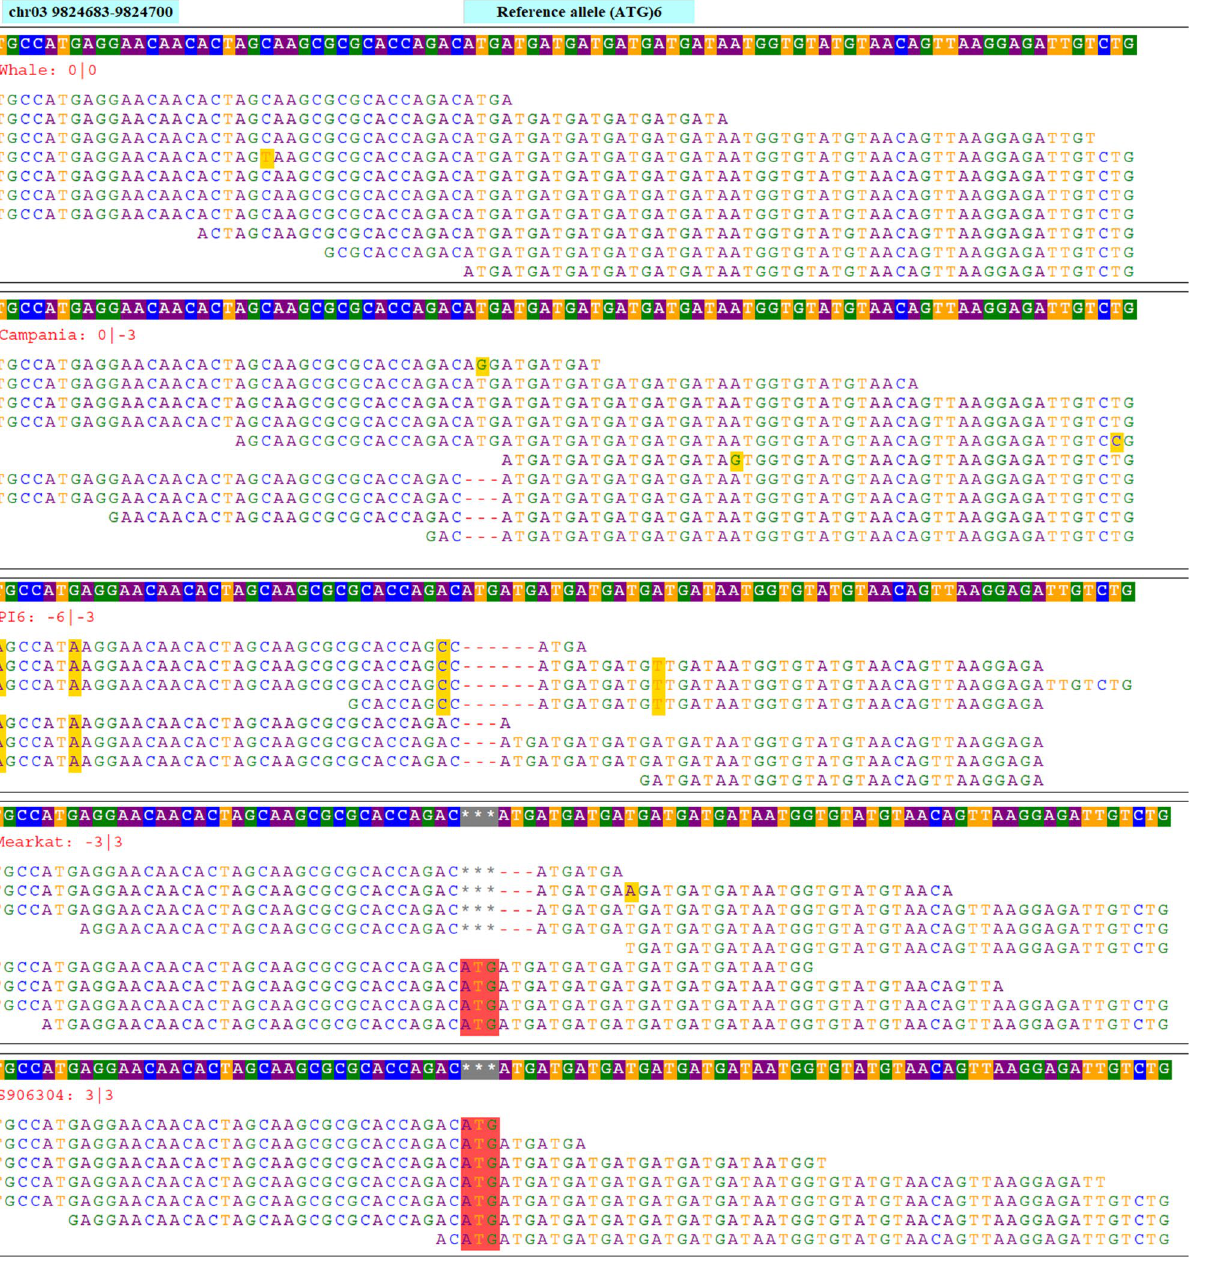
and overlapping. The accessions were grouped into three major populations and were colored using the same color code as in the STRU CTU RE plot, while cyan color was used for the admixed group (Qm). The first two principal components, PC1, and PC2 explained 10.07% and 8.24% of the overall molecular variance, and the two PC separated the accessions into three population groups, despite some overlaps. Cluster 1 contains the Q1 accessions, cluster 2 contains Q2 accessions, cluster 3 contains Q3 accessions, and the admixed accessions are colored with cyan color are in the center of the three clusters. The genetic diversity in the spinach panel was analyzed using the maximum likelihood method based on the Tamura–Nei model 45 in MEGA 7 46 . The phylogenetic analysis of 48 spinach accessions with the newly developed genome-wide 34 SSR markers showed three separate spinach accession clusters with some overlaps (Fig. 7).